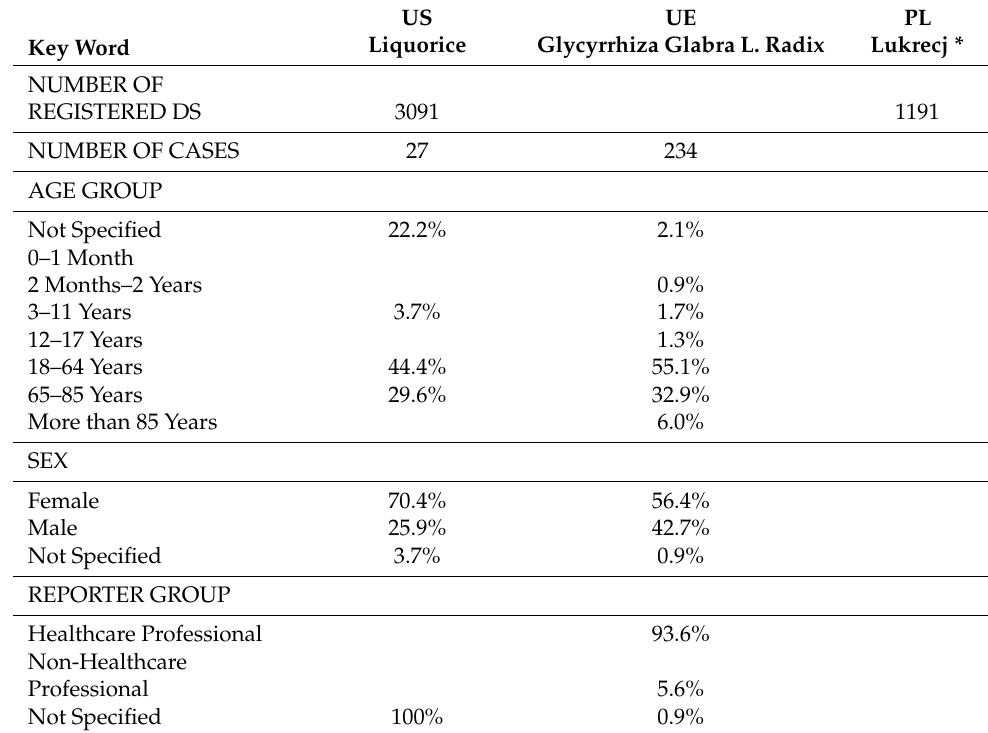
Table 3. Comparison of data on Liquorice from different databases.